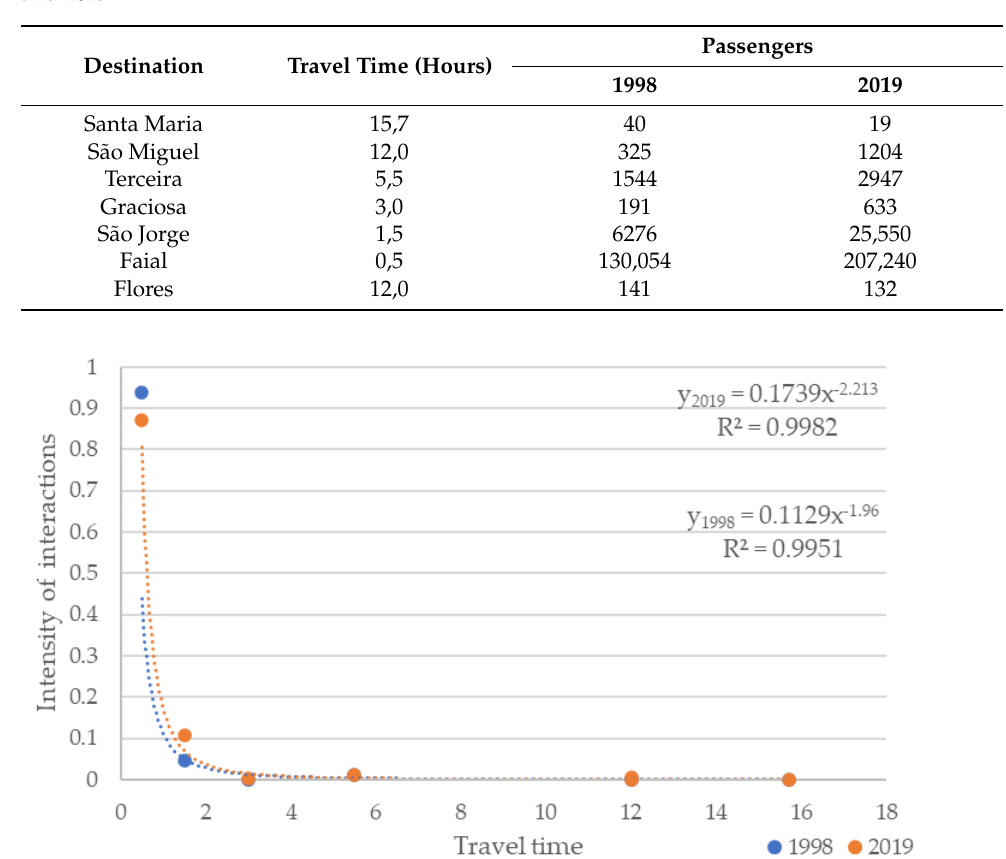
Table 2. Data for maritime connections to Pico Island from the rest of the archipelago — for 1998 and 2019.